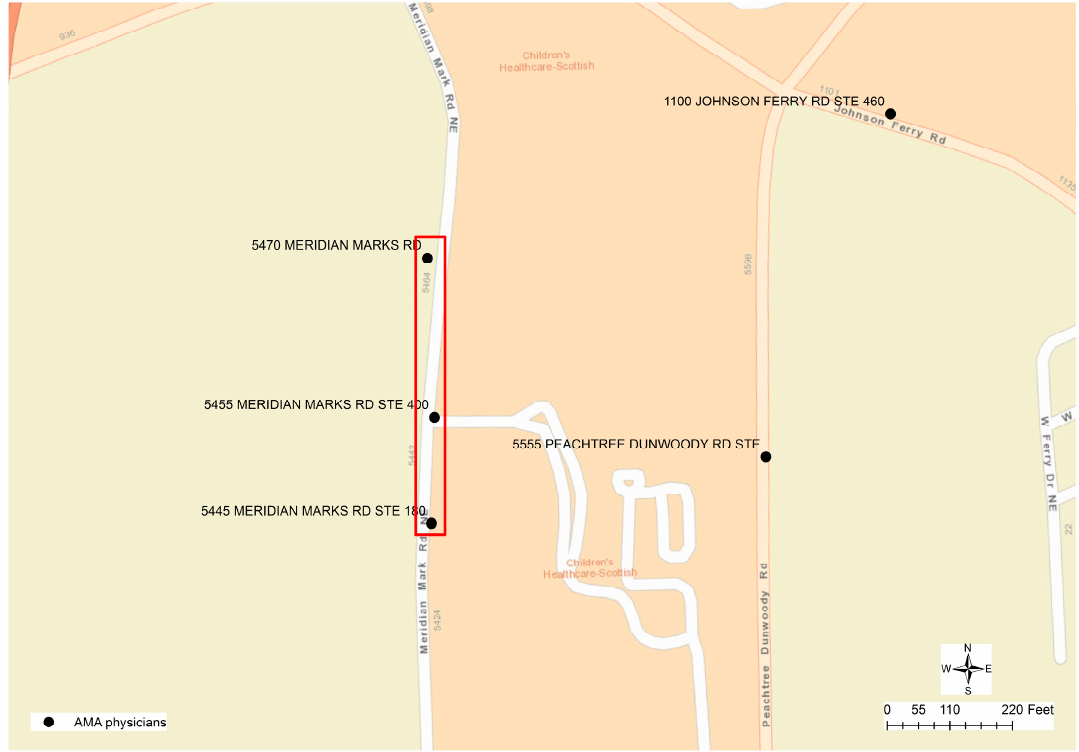
Figure 6. Misspelling error in physician data.